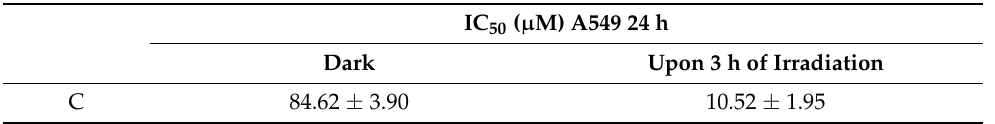
Table 1. Half maximal inhibitory concentration (IC 50 ) values of A549 cells treated with Ru(II) half- sandwich complex C in dark conditions and after 3 h of irradiation.